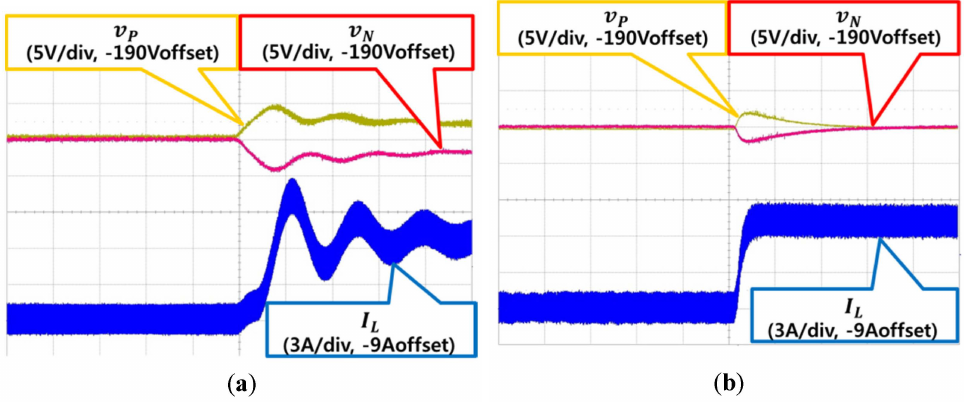
Figure 13. Performance comparison in voltage balancing: ( a ) One PI voltage control; ( b ) Two cascaded PI